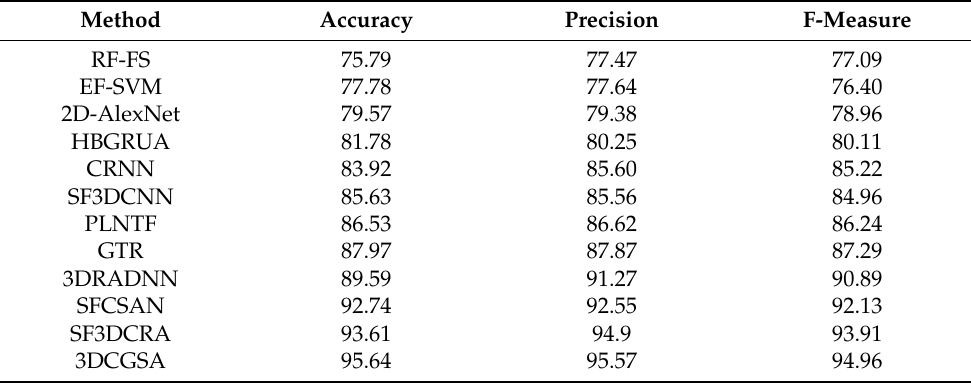
Table 2. Stress recognition results using the VRE dataset.